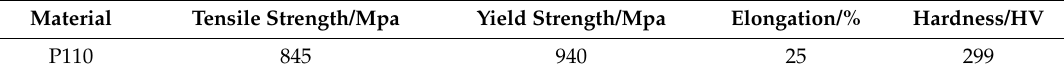
Table 5. Mechanical properties of P110.